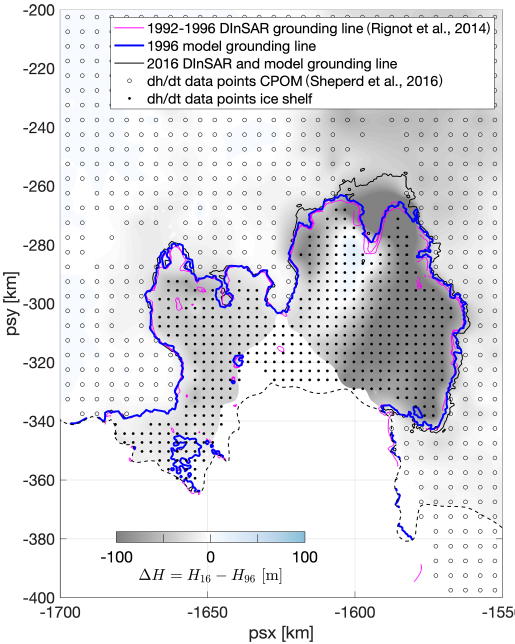
Figure A1. Ice thickness changes ( (cid:49)H ) between 1996 and 2016, based on a comprehensive analysis of satellite altimeter data. The altimeter data coverage is represented by dots (ice shelf) and cir- cles (grounded ice; Shepherd et al., 2016). The final 1996 ice thick- ness distribution was obtained by subtracting (cid:49)H from the 2016 BedMachine ice thickness (Morlighem et al., 2020), as described in Sect.2.1. The associated 1996 grounding line location (blue line) compares well to independent DInSAR measurements (magenta line; Rignot et al.,